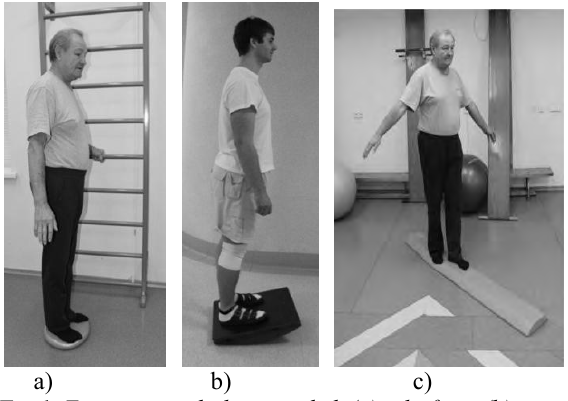
Fig.1. Exercises on balancing disk (a), platform (b), treadmill